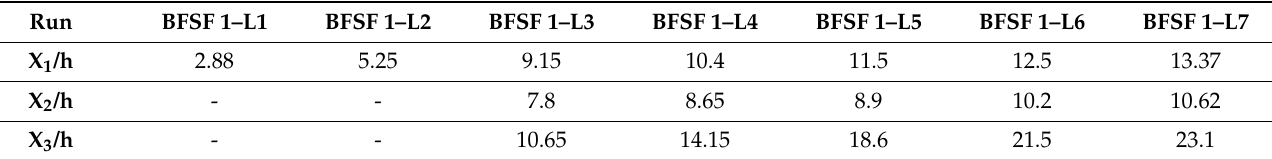
Table 7. The reattachment and separation points of the recirculation zones vs. Re h in laminar flow.